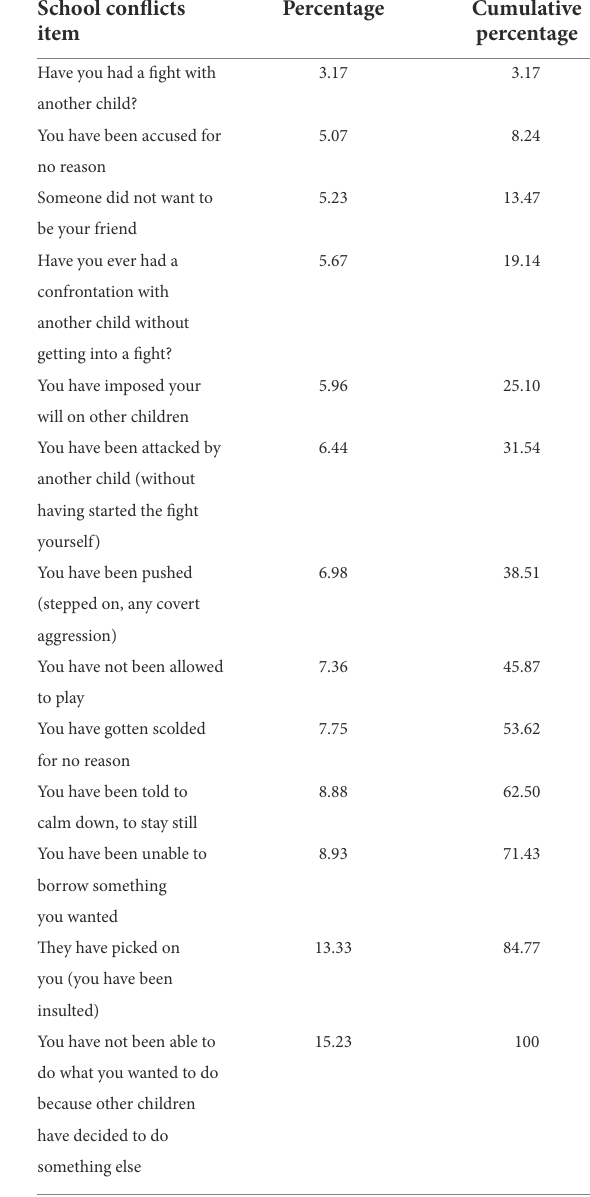
TABLE 2 Frequency distribution of items in the family conflict daily record.